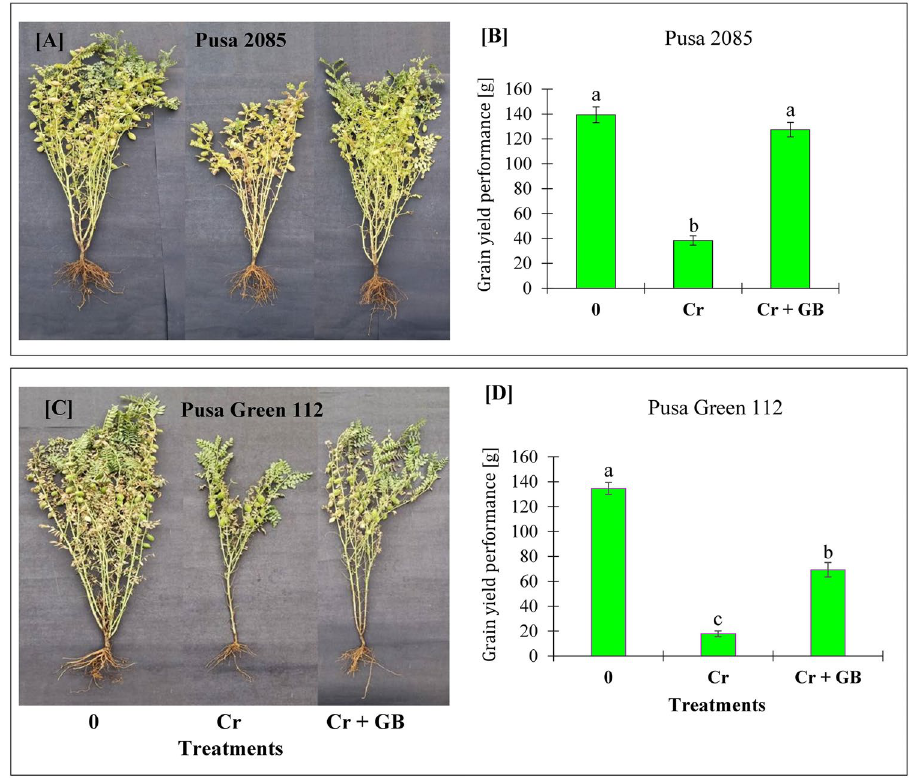
Figure 8. Effect of different stress levels of Glycine Betaine (GB) and Chromium (Cr), 0 and 120 μM Cr and 120 μM Cr + 100 mM (GB), on grain yield performance of both chickpea cultivars, ( A,B ) Pusa 2085 and ( C,D ) Pusa Green 112 at 140 days after sowing (grown in